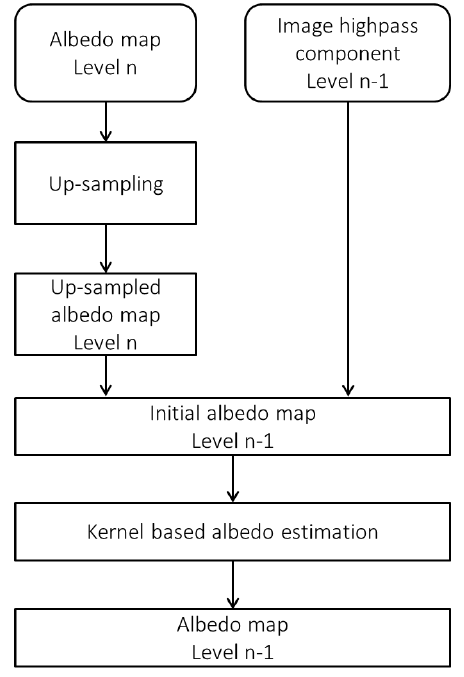
Figure 3. Algorithm for hierarchical albedo